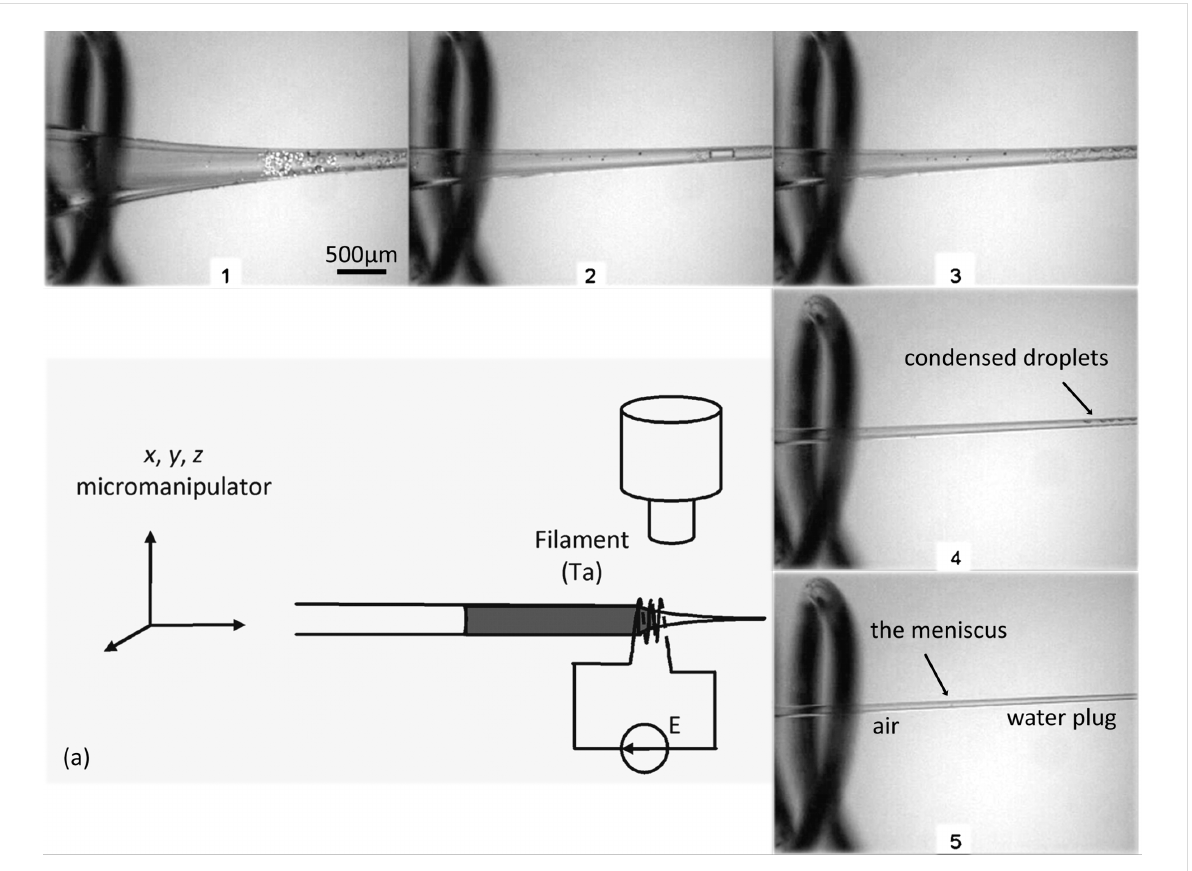
Figure 4: (a) Experimental setup of the new filling technique. The nanopipette is inserted into a tantalum loop (wire diameter: 250 µm, filament diame- ter and length: 5 mm) powered electrically by a stabilized generator ( V = 3 V, I = 3.5 A). The nanopipette can be moved with a piezoelectric ( x , y , z ) manipulator and is loaded with water up to its millimeter-to-micrometer region using a micro-syringe. The loop of the filament is placed under an optical microscope. Images 1 to 5 illustrate the process. (1) The heated filament brings the water to a boil inside the capillary; water re-condenses on the cold wall of the nanopipette. (2) The capillary is moved to heat the part where the water has re-condensed as droplets. (3) The droplets are boiled again and water is re-condensed further on the next cold part of the nanopipette. (4) The process is repeated. (5) The water is re-condensed at the very end of the tip; the meniscus formed by the water plug is visible under the optical